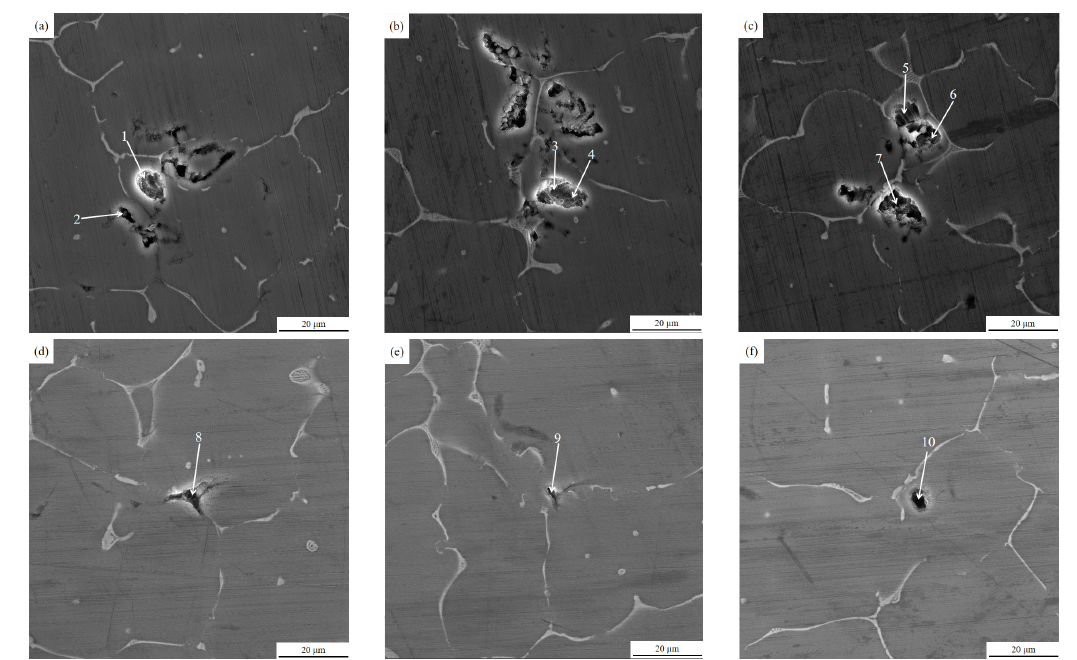
Figure 7. Inclusions in melt specimens before and after ultrasonic purification: ( a – c ) for specimens (before treatment), ( d – f ) for specimens (after treatment).